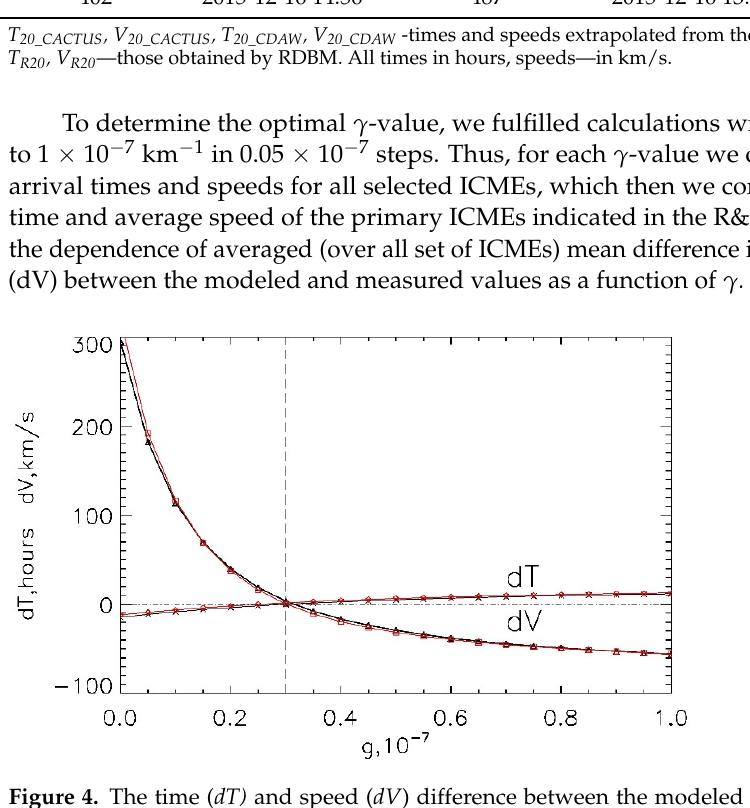
Figure 4. The time ( dT) and speed ( dV ) difference between the modeled by the ensemble SMDC arrival times and speeds of the ICMEs and start times and averaged speeds in the R&C catalog as a function of γ for the CACTus (the black lines and symbols) and CDAW (the red lines and symbols) initial data. The dashed line corresponds to the optimal γ - value.